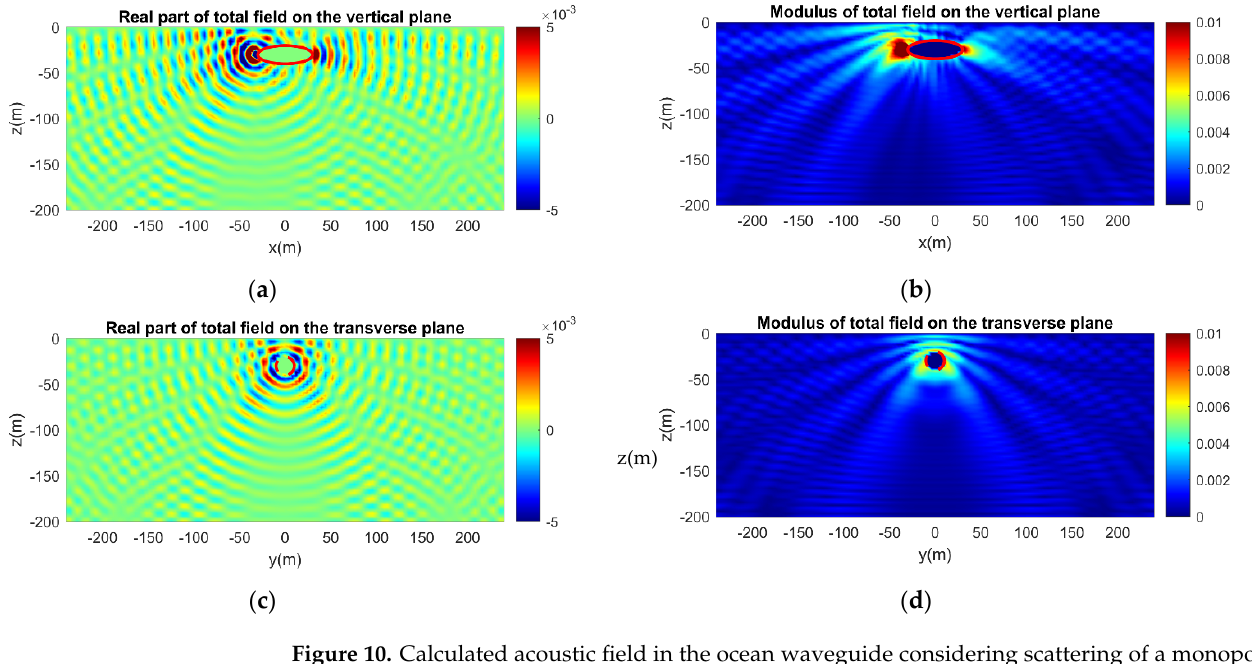
Figure 10. Calculated acoustic field in the ocean waveguide considering scattering of a monopole source field by an acoustically hard ellipsoid, with the effect of rigid sea bottom at depth h = 200 m. ( a ) Real part and ( b ) modulus of the acoustic field on the vertical plane. ( c ) Real part and ( d ) modulus of the acoustic field on the transverse plane.